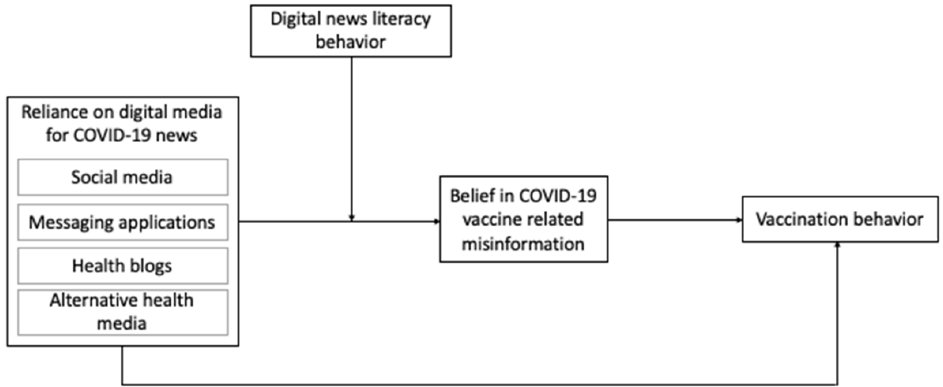
Figure 1. Theoretical framework.